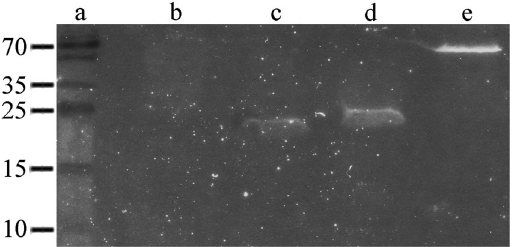
Figure 1. Western blotting to confirm the expression of Mtk in yeast. The expression of Mtk in yeast strain Y2HGold was confirmed by western blotting using a Myc-specific antibody. ( a ) Size marker (kDa). ( b ) Negative control (Y2HGold). ( c ) Empty pGBKT7 vector. ( d ) pGBKT7::Mtk. ( e ) Positive control